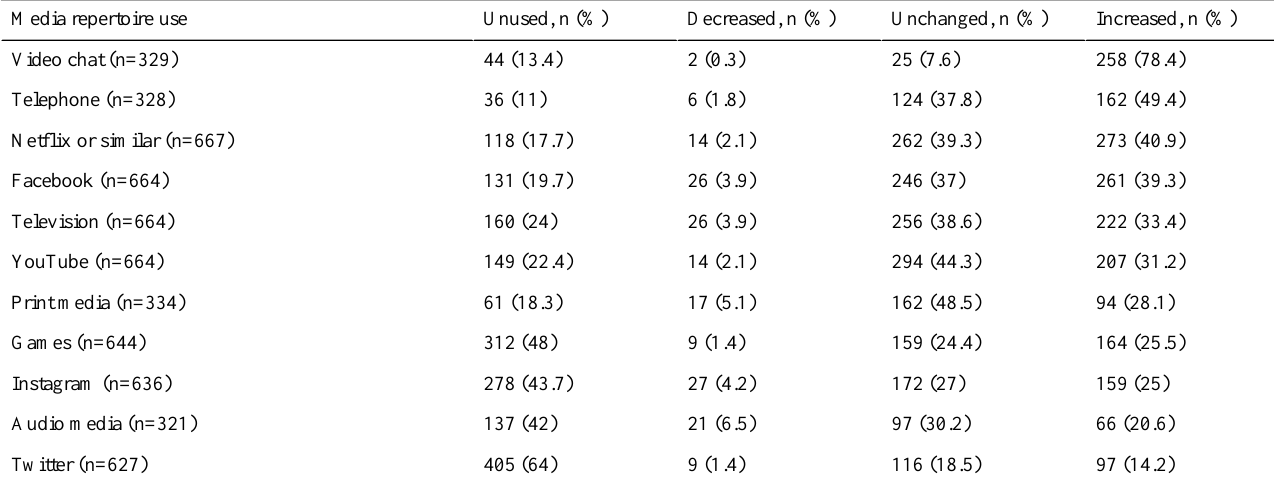
Table 3. Frequency of response to changes in media use as a result of the coronavirus disease